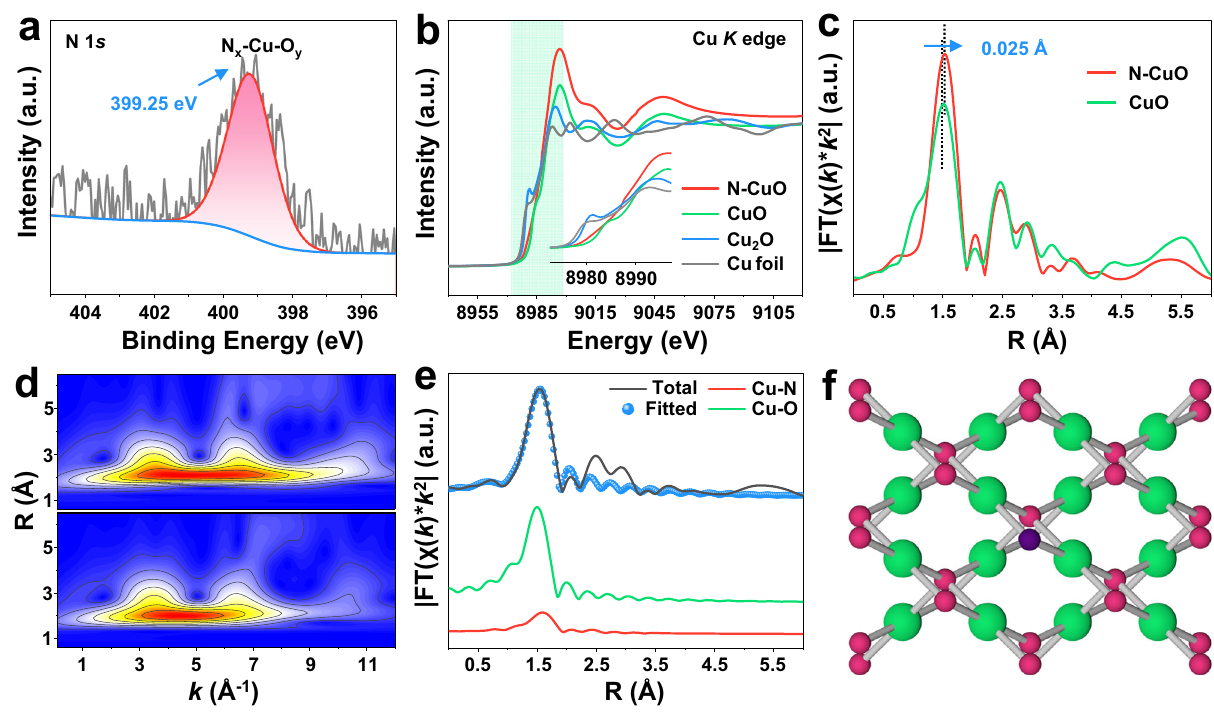
Fig. 3 | Charge distribution via N-doping strategy. a High-resolution N 1 s XPS spectrum of N – CuO. b Normalized Cu K -edge XANES spectra of N – CuO and its reference samples (Cu foil, Cu 2 O and CuO). c, d Fourier transform-EXAFS spectra